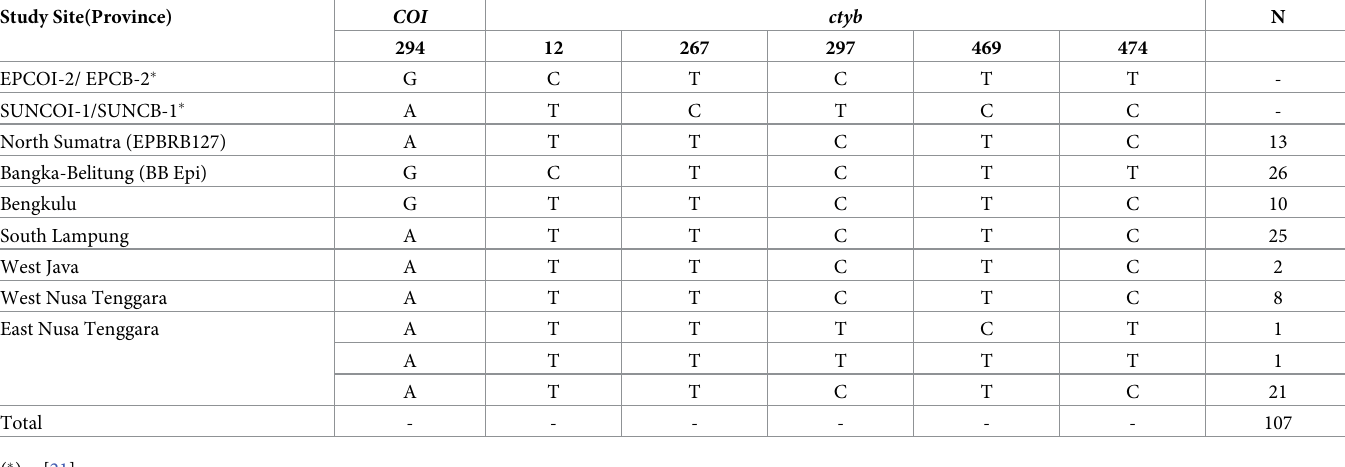
Table 2. Inter-specific variable bases for COI and cytb genes that distinguish between Anopheles sundaicus complex species. Study Site(Province) COI ctyb N 294